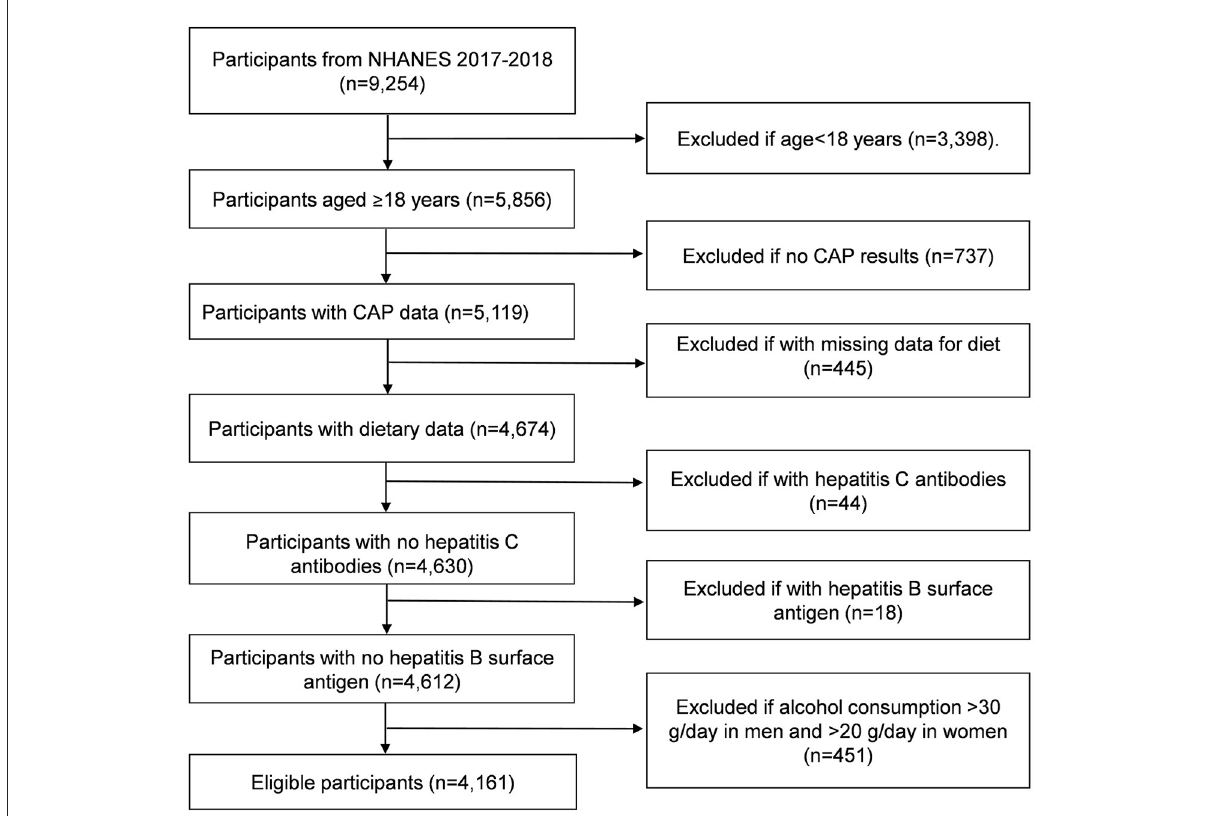
FIGURE1 Flowchart of participants from 2017 to 2018 cycle of National Health and Nutrition Examination Survey (NHANES). CAP, controlled attenuation parameter.